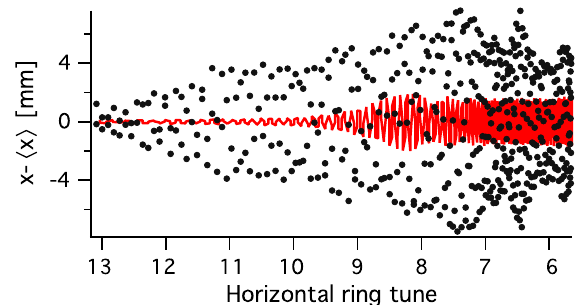
FIG. 4. Simulated distortion of the horizontal accelerated orbit versus tune in the case of where the magnets are misaligned randomly (black points) and in the case where just the ninth harmonic of the same random misalignment is retained (red line). The random misalignments have 50 μ m standard deviation. A single particle is tracked, starting on the closed orbit at the initial momentum, and its coordinate found throughout acceleration at simulated BPMs located in between each quadrupole doublet. The distortion is then calculated by subtracting from the coordinate the moving window average h x i , with the width of the window determined by the betatron oscillation wavelength. In this case, the simulated BPM readings are assumed to be ideal. Acceleration is from 10.5 to 20 . 5 MeV =c in the serpentine channel with 1.1 MV rf per